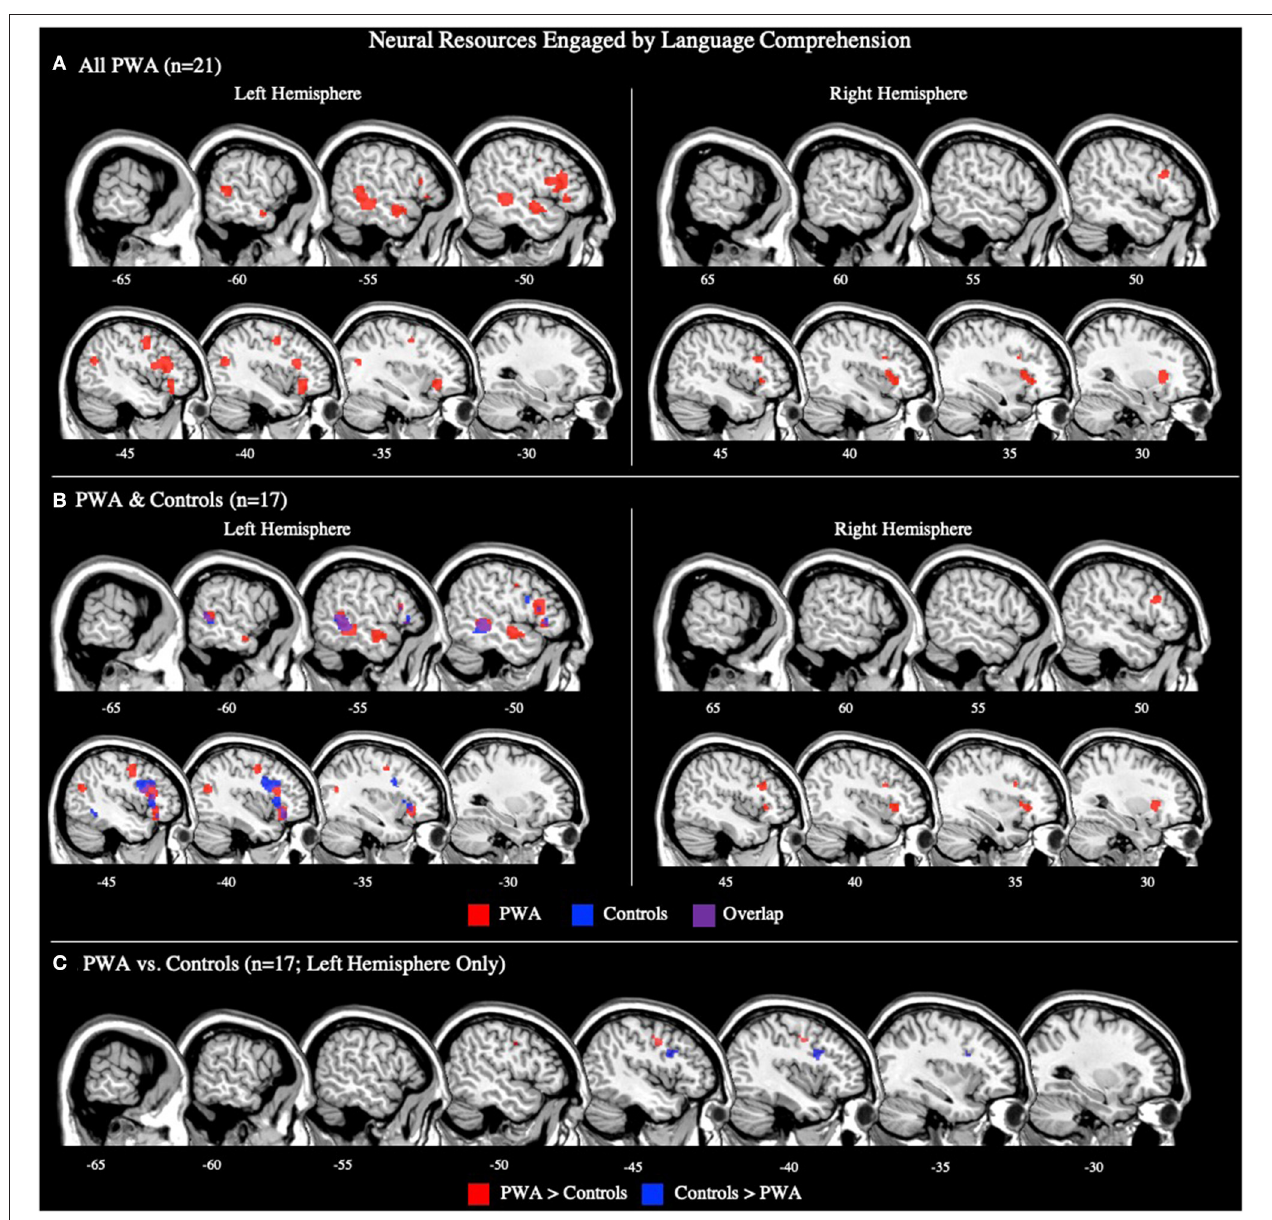
FIGURE 4 | Representative sagittal slices for the language comprehension ALEs in (A) PWA ( p < 0.001 corrected), (B) PWA and controls ( p < 0.001 corrected), and (C) PWA vs. controls ( p = 0.05 uncorrected). (B,C) only include data from tasks which included both PWA and control data. Sample size denotes the number of tasks included in the